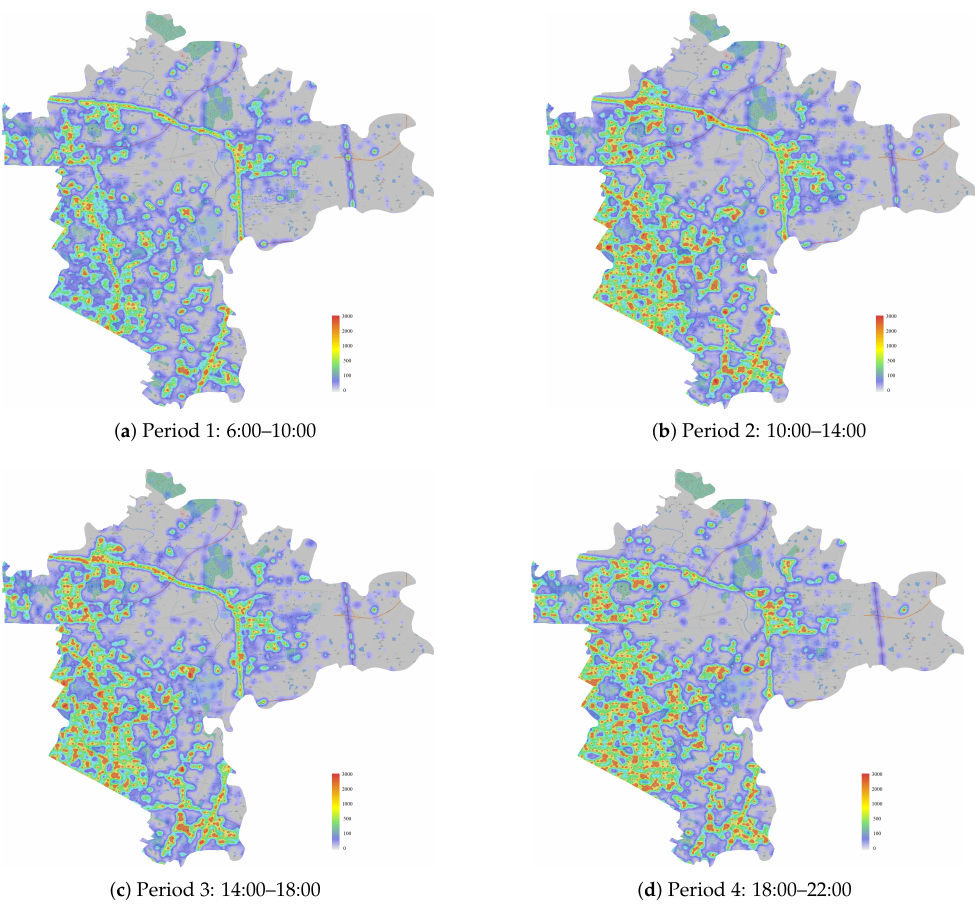
0.5%, 1.5%, 3%, and 1% of the corresponding period’s population number in Figure 4.